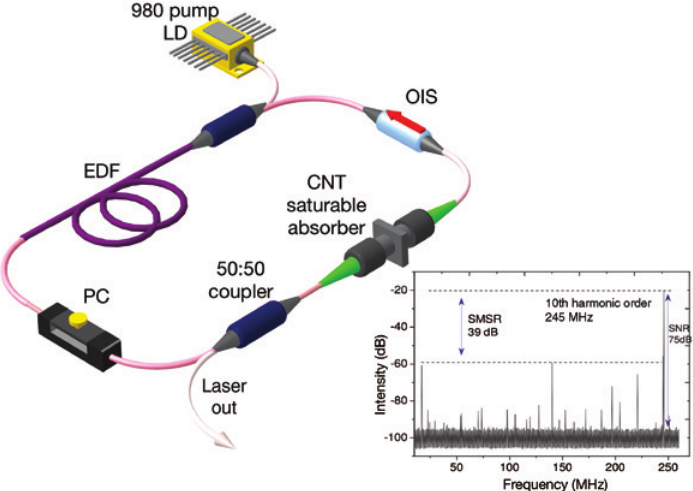
Figure 16: Schematic configuration of the harmonic mode-locked Er-doped fibre laser. EDF, Erbium-doped fibre; WDM, wavelength division multiplexor; PC, polarisation controller; OIS, isolator. Inset: RF spectrum of 10th harmonics at 245 MHz. Adapted from